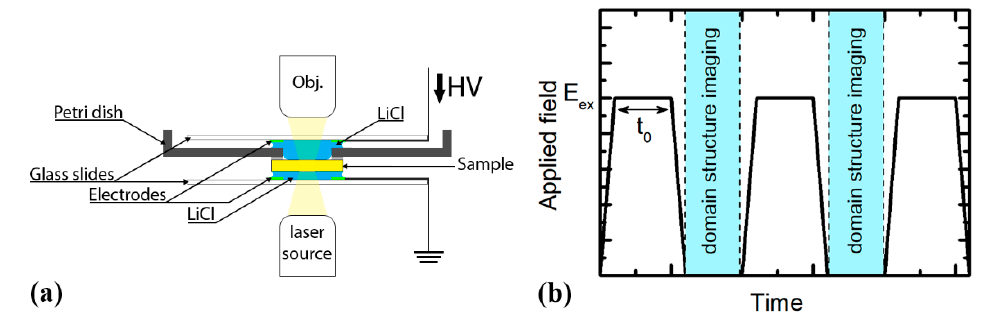
Figure 1. ( a ) The scheme of the experimental setup. ( b ) The scheme of the applied field pulse series with domain structure imaging intervals.